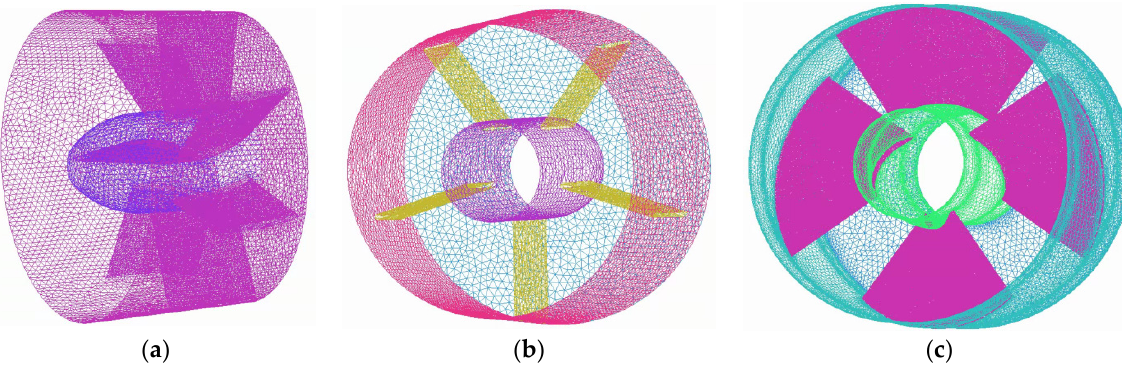
Figure 3. Grid of fluid calculation domain. ( a ) Guide vanes, ( b ) front guide vanes, ( c ) impeller.